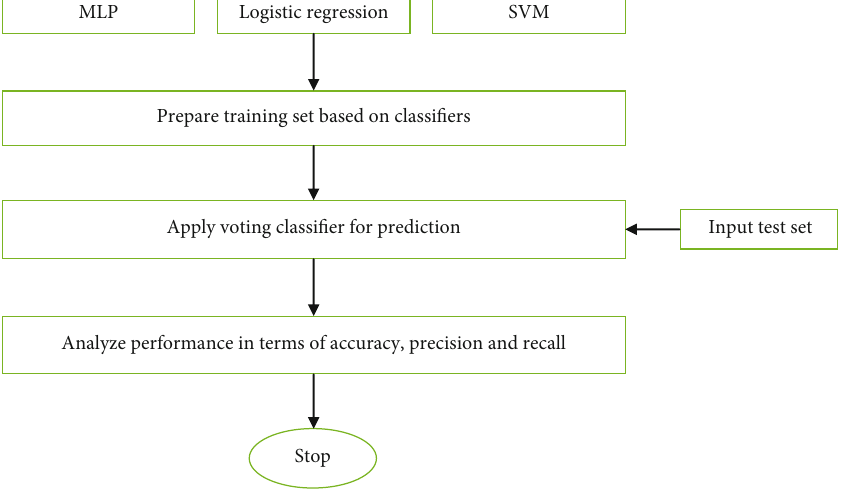
Figure 5: Ensemble 4 classi fi er Table 3: Performance of ensemble classi fi ers on dataset 3. Table 1: Performance of ensemble classi fi ers on dataset 1.